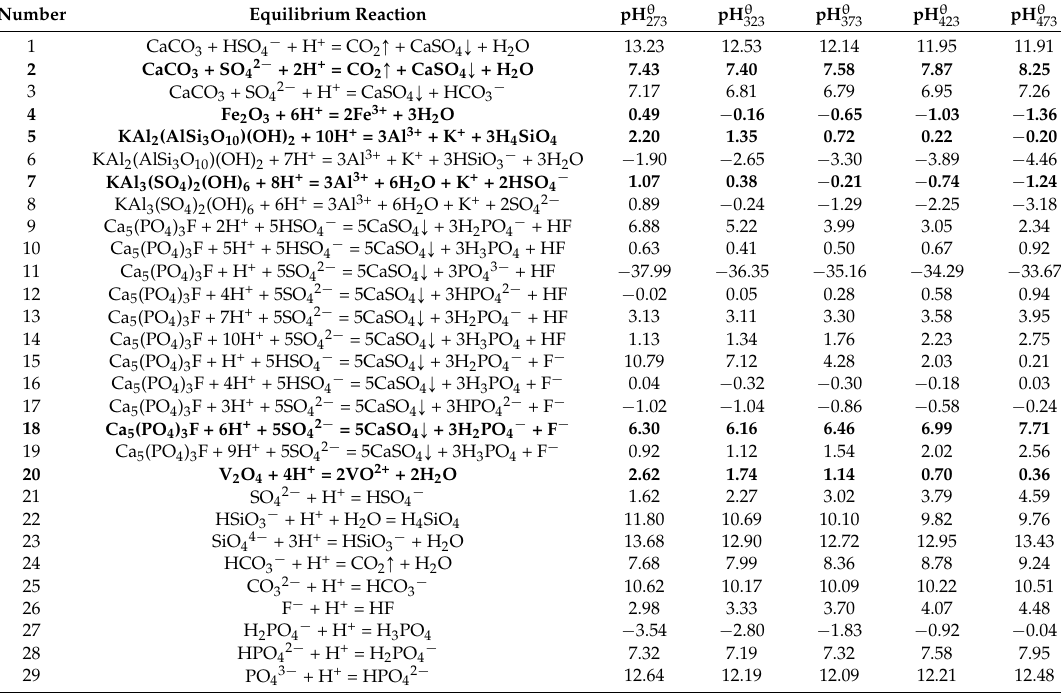
Table 4. pH θ of different equilibrium reactions at 373–473 T